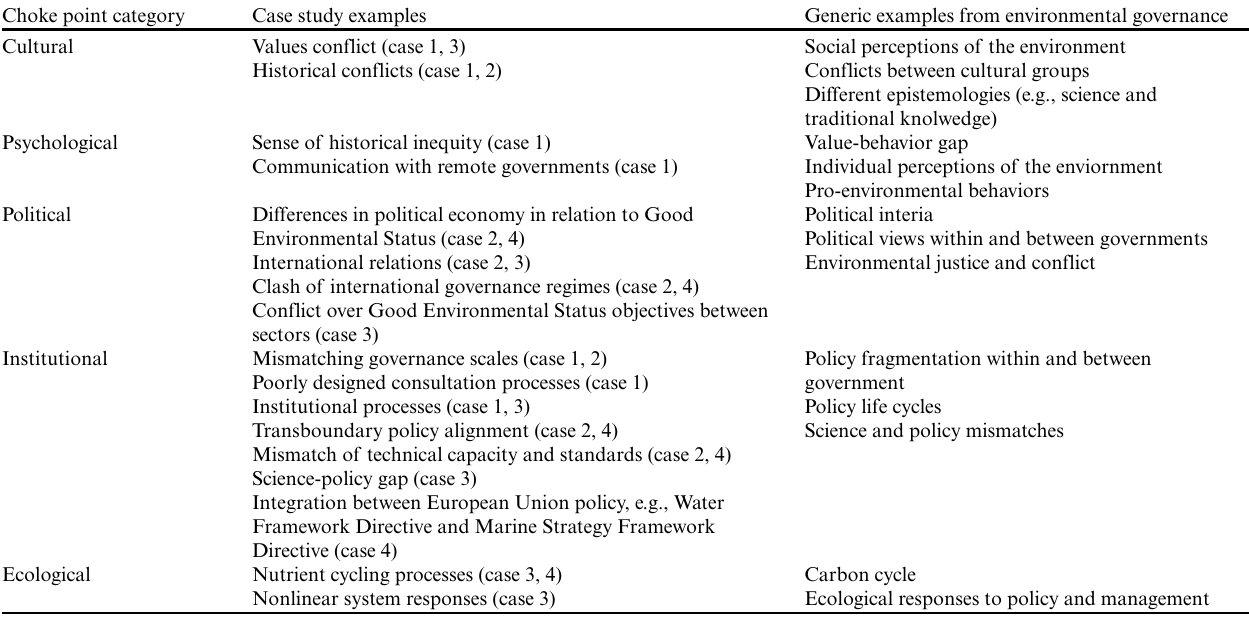
Table 2. Choke points identified in the case studies, and generic